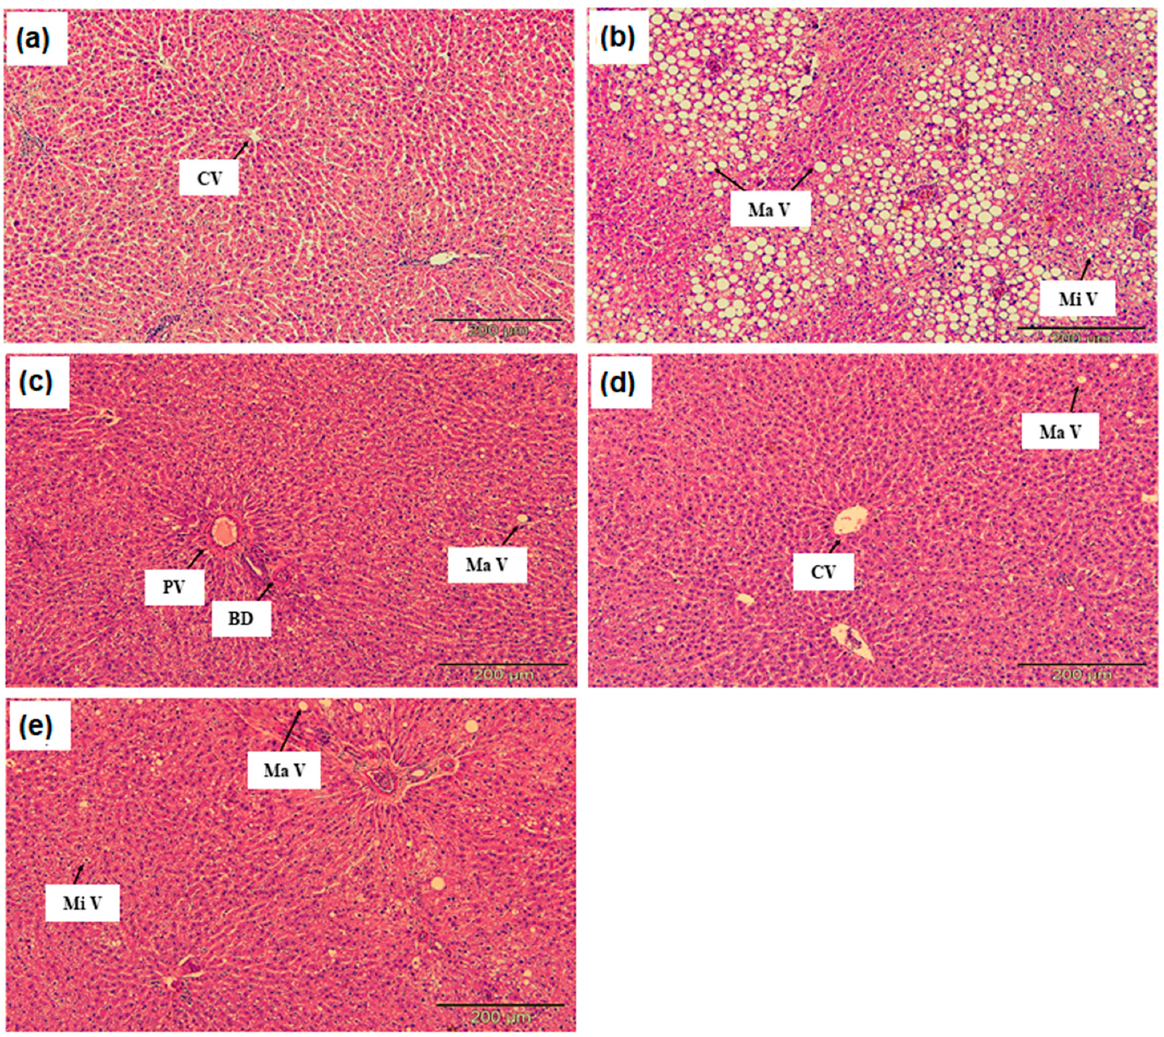
Figure 1. ( a ) Histology section of liver tissue in the normal rat group (NG), ( b ) hypercholesterolemic positive control rats group (PG), ( c ) hypercholesterolemic rats treated with 2% DPO (HG), ( d ) hypercholesterolemic rats treated with 2% DDP (DG) ( e ) hypercholesterolemic rats treated with 10 mg/kg simvastatin (SG) observed under a light microscope at 200 × magnification (hematoxylin and eosin staining). CV: central vein; MaV: macrovesicular steatosis; MiV: microvesicular steatosis; PV: portal vein; BD: bile duct.